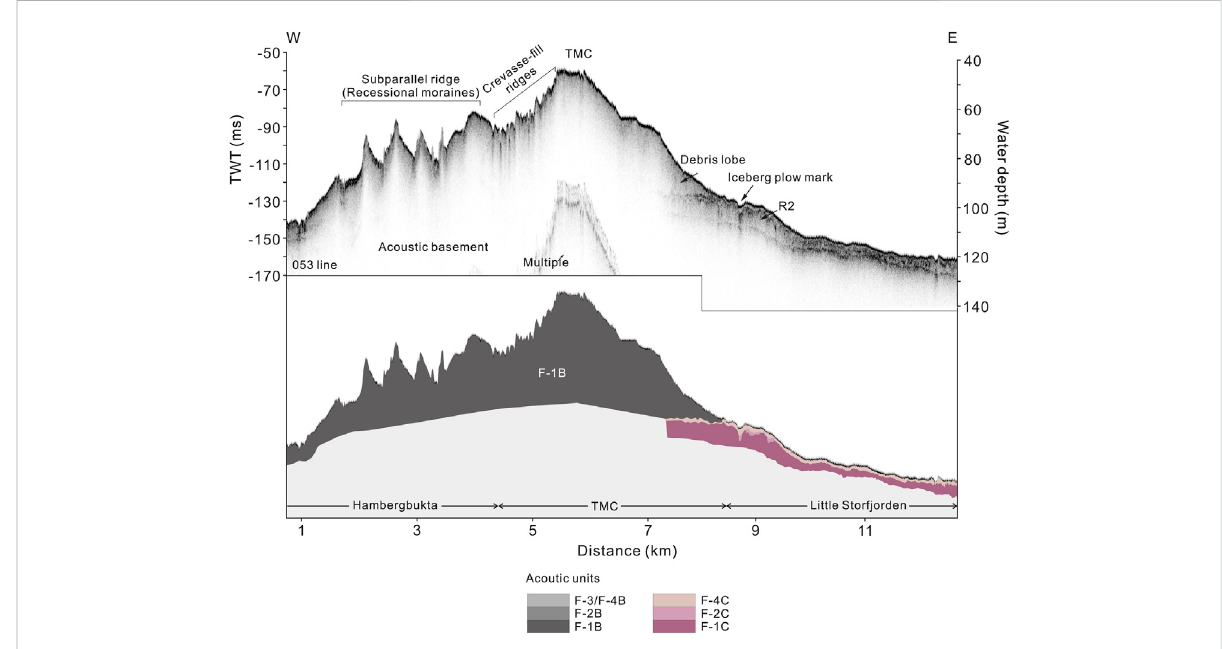
FIGURE 5 SBP pro fi le (053 line) at the mouth of Hambergbukta showing a grounding zone wedge below the TMC and the associated debris